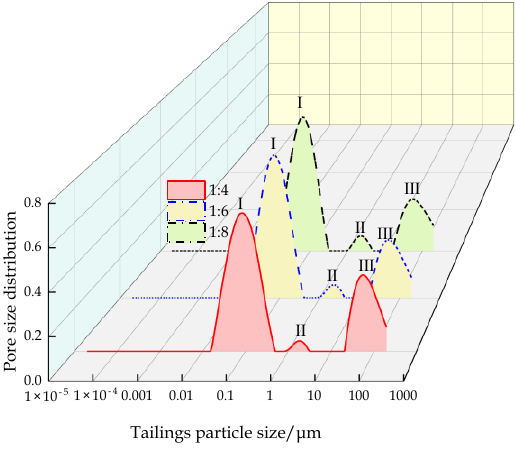
Figure 5. Pore size distribution of